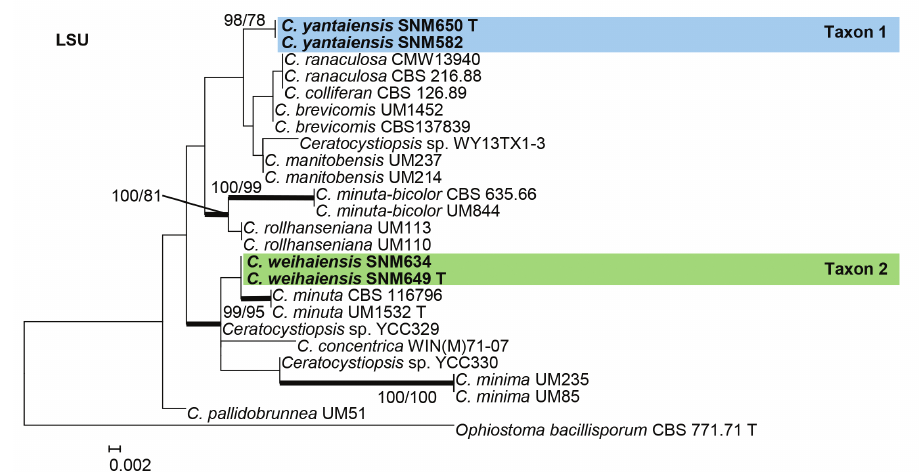
MycoBank No: 839252